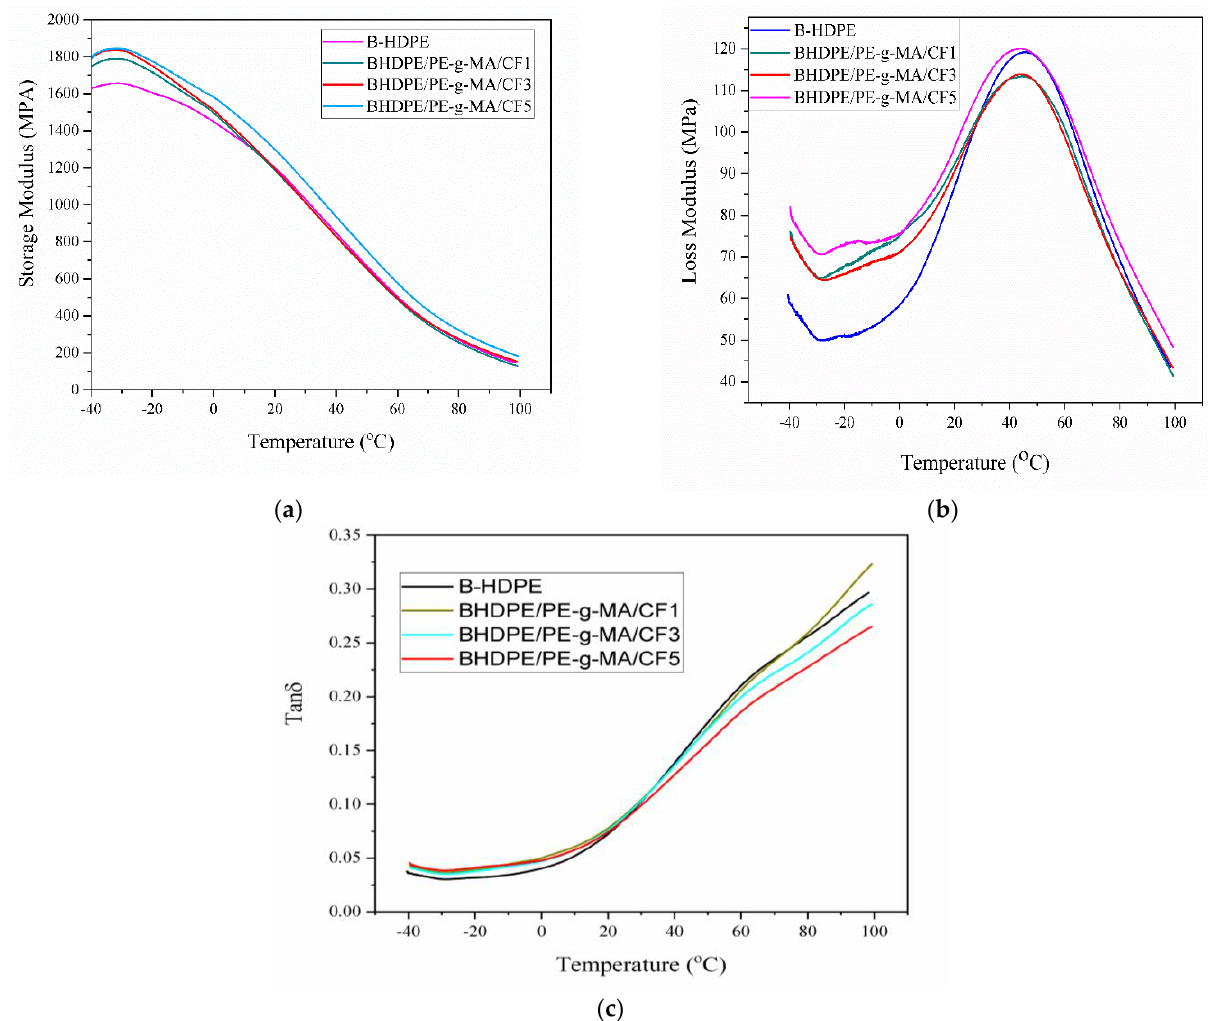
Figure 8. Typical DMA analysis curves: ( a ) storage modulus, ( b ) loss modulus and ( c ) tan δ . The storage modulus (E (cid:48) ) is related to the resistance capacity of the material to Relaxation ( α ) is associated with the mobility of long chain segments in the crystalline phase [50,51], being more susceptible than the other transitions due to the restrictions im- posed on the segmental mobility of the polymer with the addition of reinforcement [52].